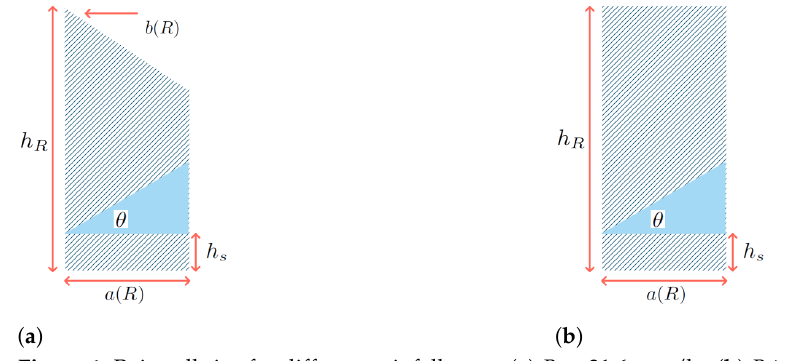
Figure 1. Rain cell size for different rainfall rates: ( a ) R < 31.6 mm/h , ( b ) R ≥ 31.6 mm/h